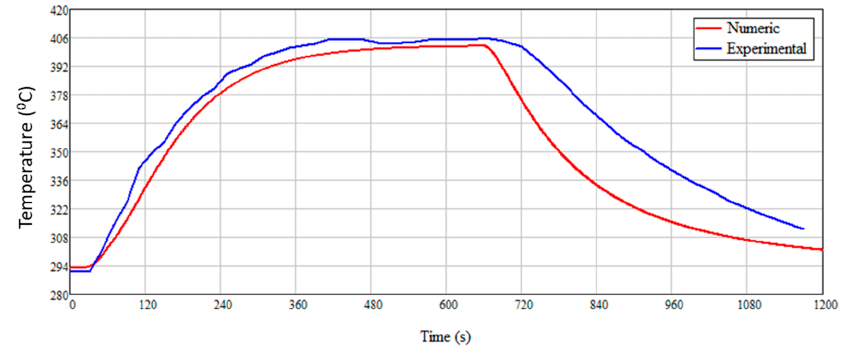
Figure 10. Temperature variations on the right side of shield 2, determined numerically and experimentally.